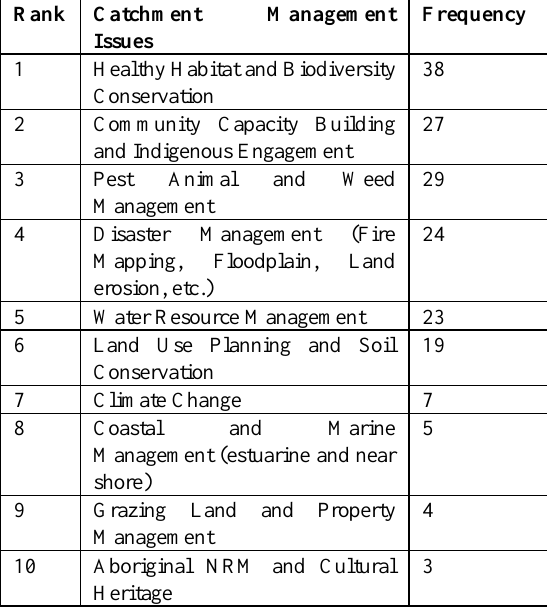
Table 1. Main catchment management issues